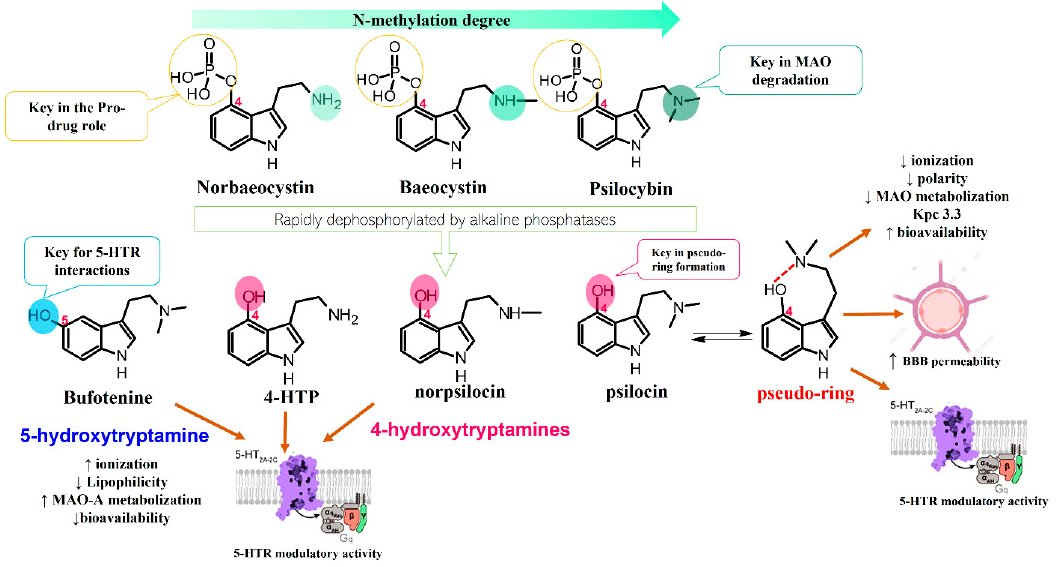
Figure 4. Important structural motifs of tryptamines and their pharmacodynamic and pharmacoki- netic correlation in neuropharmacology.